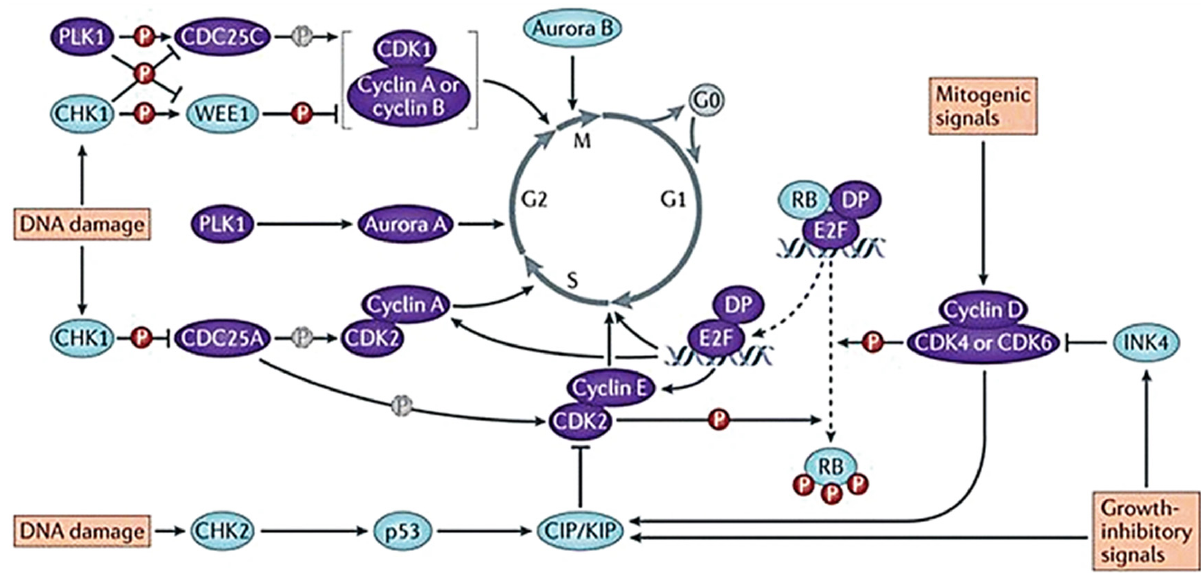
Figure 5. Evolution of the cell cycle and the main regulator proteins. The positive regulators of cell cycle progression are in purple while the negative regulators are in blue. Adapted from [84].